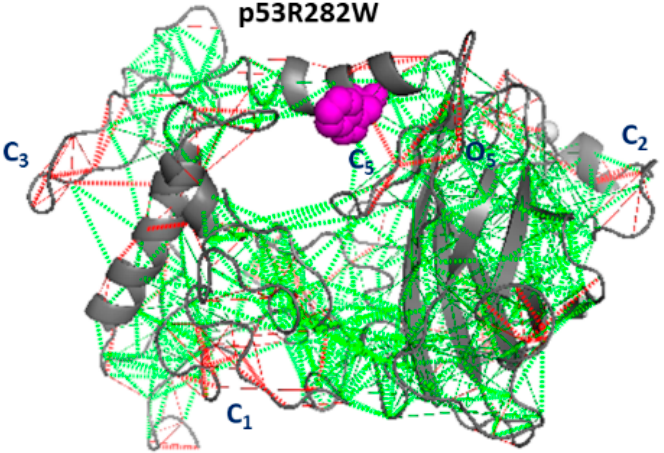
Figure 11. Frustration analysis of p53R282W. The level of frustration is represented by the colored scale: green represents minimal frustration and red high frustration. The mutated residue (282W, magenta) and the Zn ion (grey) are represented as spheres.